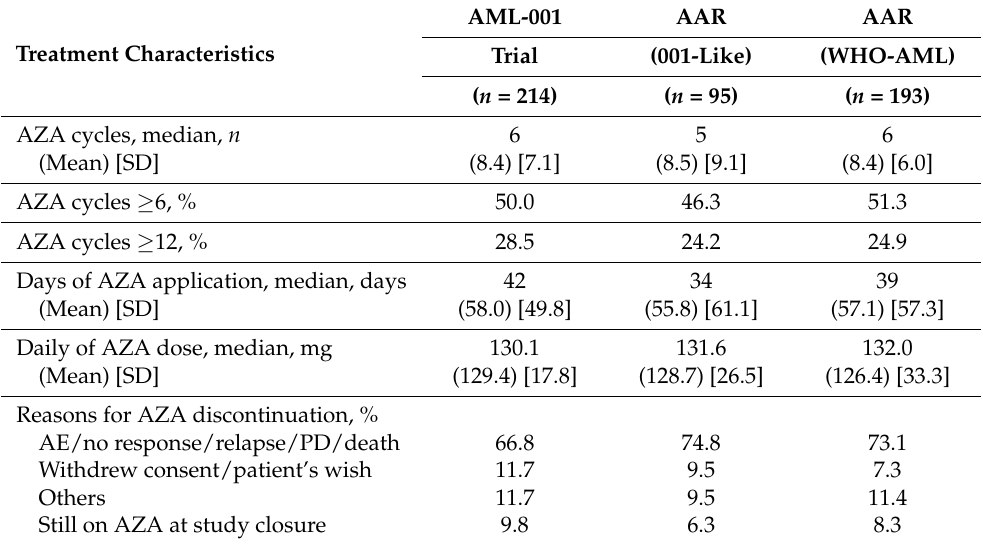
Table 2. Treatment characteristics of AML patients treated with azacitidine front-line per patient